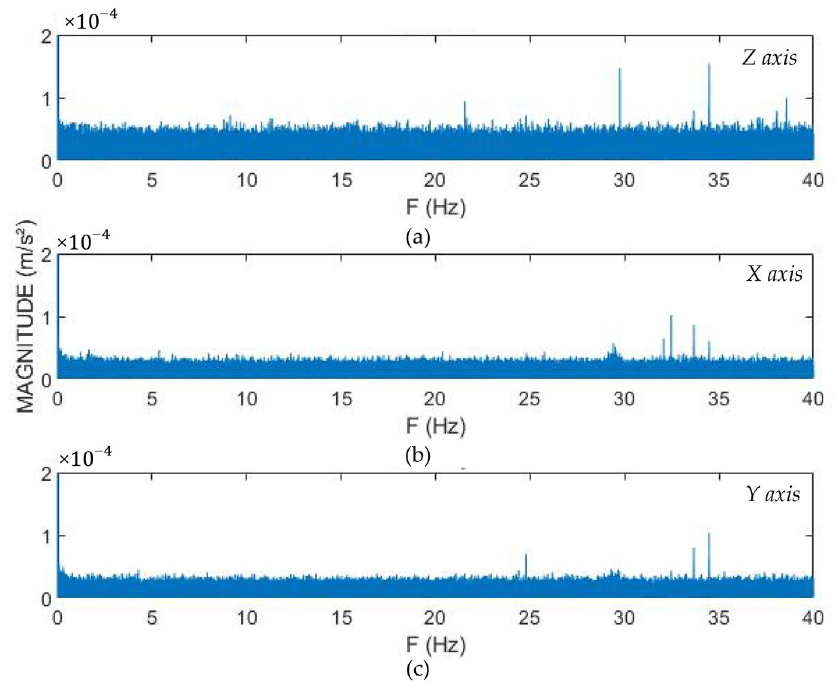
Figure 3. Frequency domain diagrams of LARA for: ( a ) z , ( b ) x, and ( c ) y -axis.